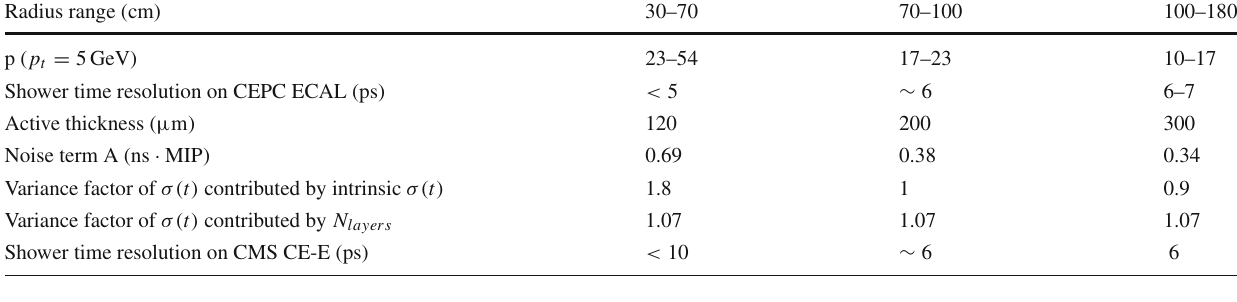
Fig. 15 The shower time resolution as a function of R value for perfect clusters and Arbor clusters in the photon (left) sample and the pion (right) samples. The error bars are multiplied by a factor of five for visibility